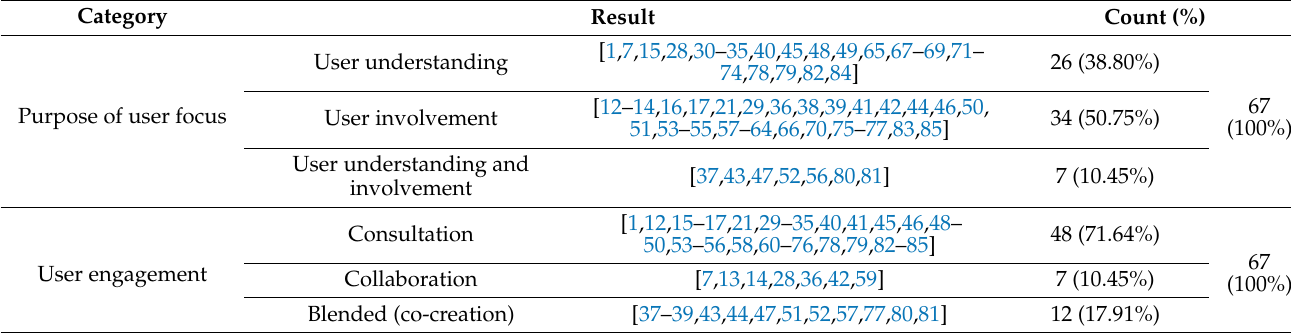
Table 6. Purpose of user focus and engagement